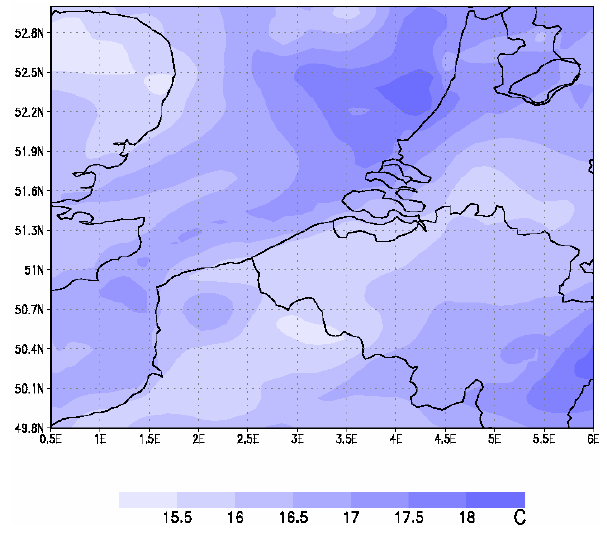
F8 Fig. 8. Potential temperature ( ◦ C) above the southern North Sea at 40m on 13 August 2004 03:00 UTC, as calculated by MM5.